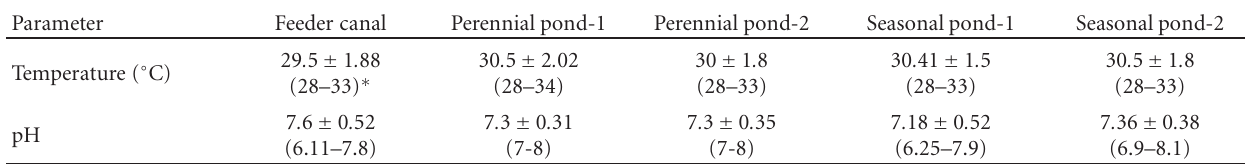
Table 2: Temperature and pH (Mean ± SD) of the sediment of feeder canal and the